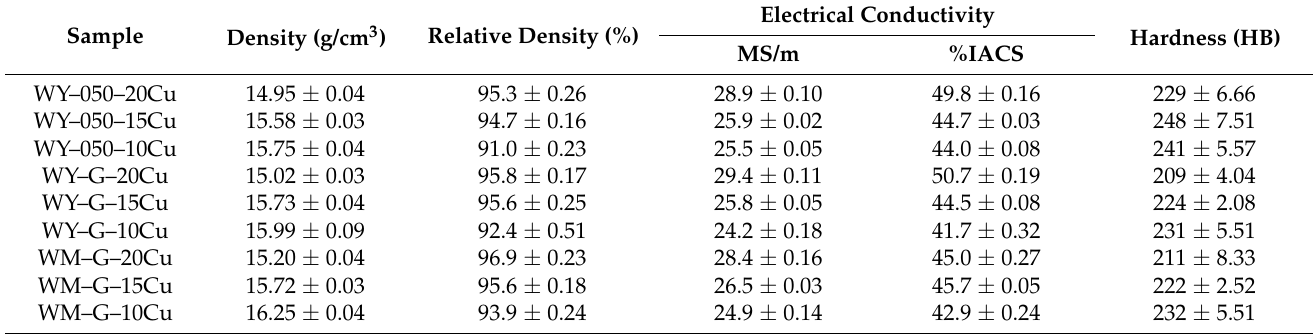
Table 3. Density, electrical conductivity, and hardness of the as-prepared W–Cu